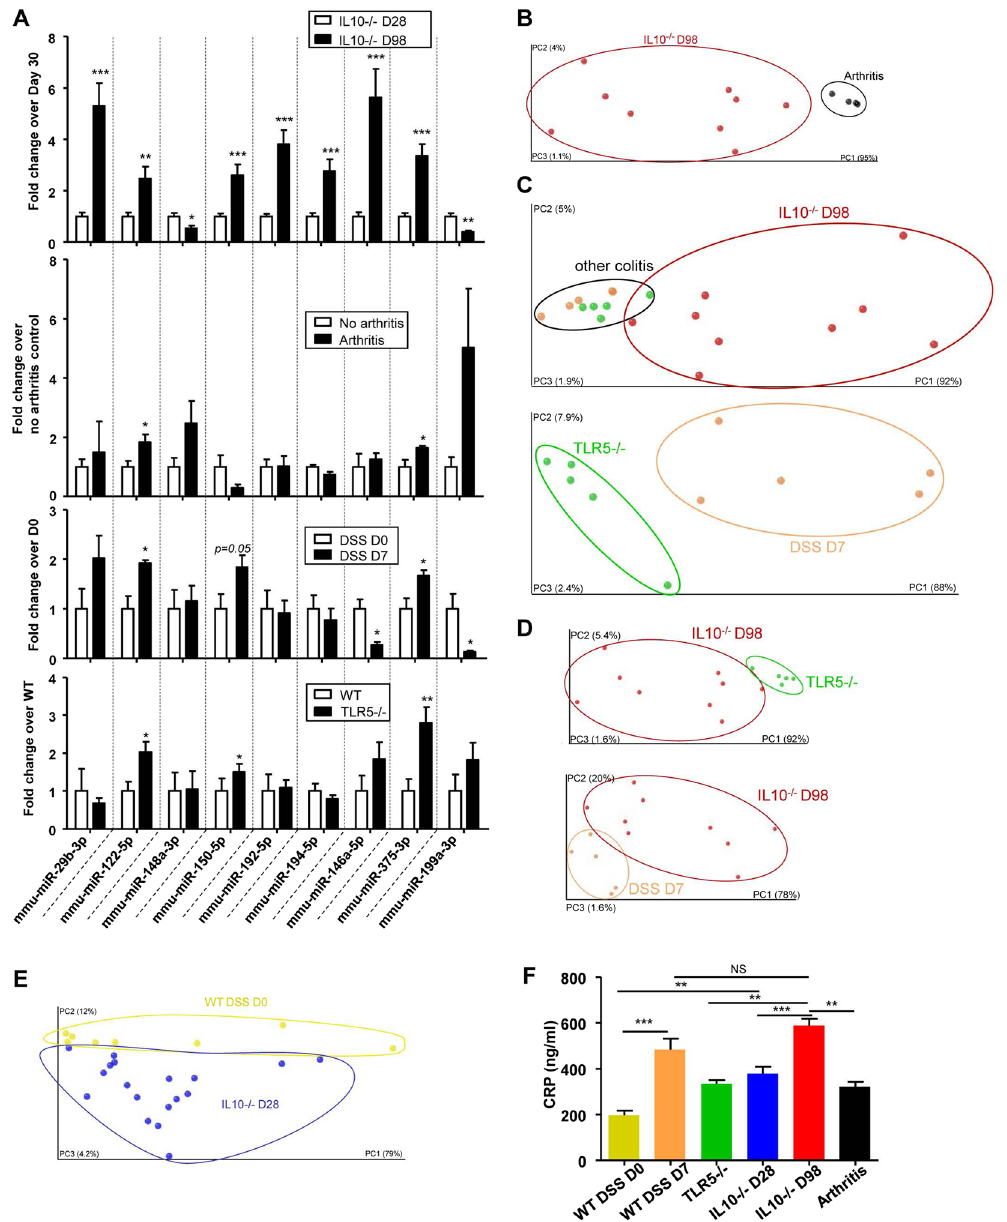
Figure 3. New miRNA signature specificity for intestinal inflammation and discrimination between different subtypes of colitis. Sera representing three different mouse models of colitis (IL10 − / − , TLR5 − / − and DSS- induced colitis) and arthritic mice were collected. ( A ) Fold changes of the nine signature miRNAs in IL10 − / − (D98), arthritic (day 12) mice, 3% DSS-induced-colitic and TLR5 − / − , compared to the relevant controls [28 day- old IL10 − / − mice, Balb/C mice before the establishment of arthritis (day 2), water-control C57BL/6 WT mice and C57BL/6 WT mice]. ( B – E ) PCoA of the euclidean distance matrix of the 9 miRNA expression in sera of various mouse models was performed using QIIME software and plotted using Emperor Software. Percentages on the axes indicate the percentage of variance explained by each component. ( B ) IL10 − / − mice at D98 (red) compared to sera of arthritic (black) mice; ( C ), IL10 − / − colitic mice (day 98, red), TLR5 − / − mice (green) and DSS-induced colitic mice (orange); ( D ), IL10 − / − colitic mice on day 28 (blue) and D98 (red) compared to TLR5 − / − and DSS-induced colitic mice; and ( E ) IL10 − / − mice at D28 (blue) compared to WT water-treated control mice (DSS D0, yellow). ( F ) CRP levels were measured in the sera of WT, D7 DSS, TLR5 − / − , D28 IL10 − / − , D98 IL10 − / − and arthritic mice. Data are presented as the means + / − S.E.M. (n = 5–18). Significance was determined using unpaired t-test (A) or using One-way ANOVA followed by a Bonferroni post-test ( F ) ( * p < 0.05; ** p < 0.01; *** p < 0.001; and NS, not significantly different) compared to the corresponding non- inflamed